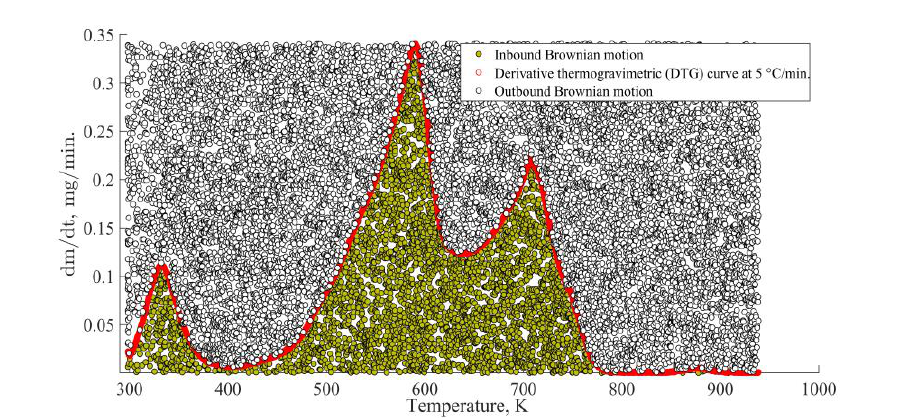
Fig. 1. Brownian motion of inbound and out bound particles on the DTG plane at 5